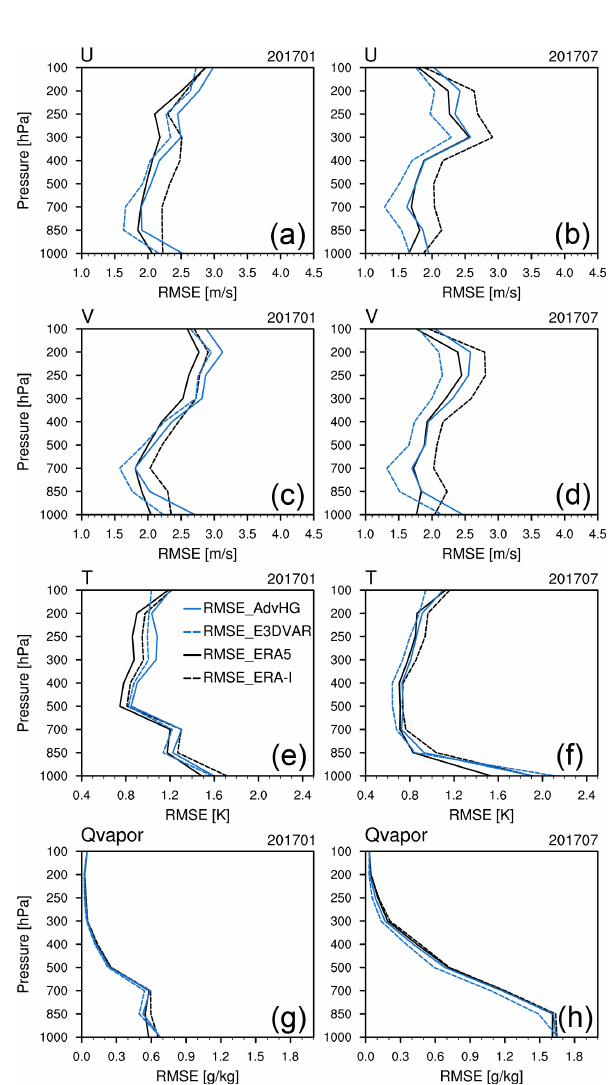
Figure 3. RMSEs in analysis of (a, b) zonal wind, (c, d) merid- ional wind, (e, f) temperature, and (g, h) Qvapor (water vapor mix- ing ratio) from ERA-I (dashed black line), ERA5 (solid black line), E3DVAR (dashed blue line), and AdvHG (solid blue line) depend- ing on pressure levels for (a, c, e, g) January and (b, d, f, h) July